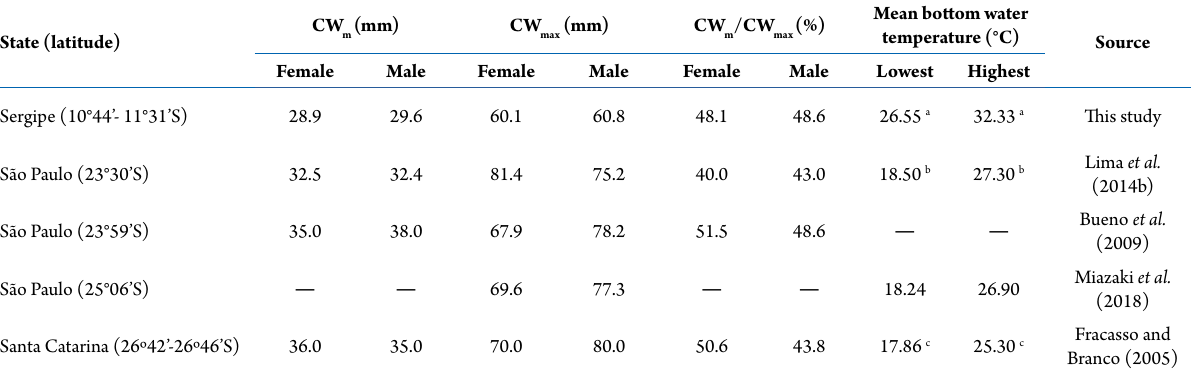
Table 3. Length at first maturity (CW temperature along the Brazilian coast.